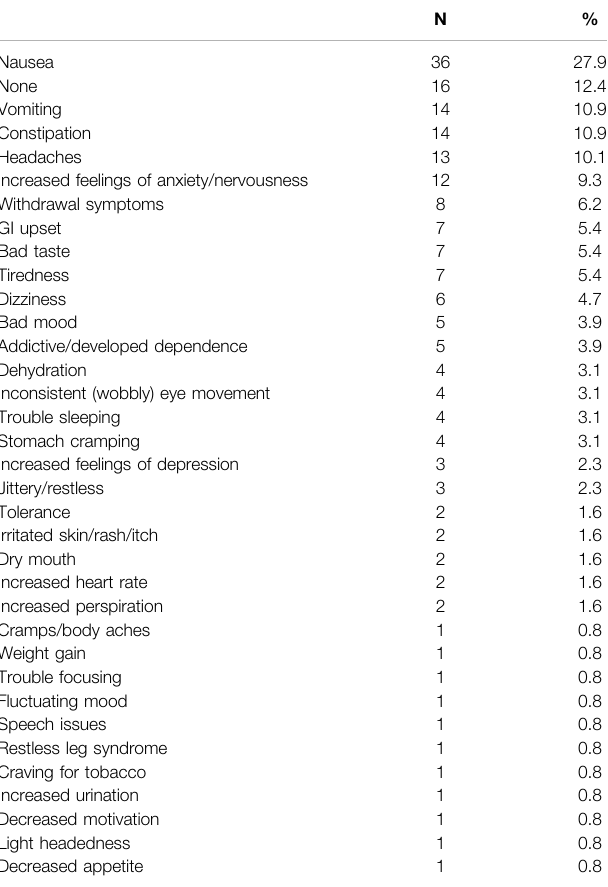
TABLE 3 | Adverse or unwanted side effects reported by participants as being directly caused by kratom use via open text response quanti fi ed in raw number and percent frequency (n =